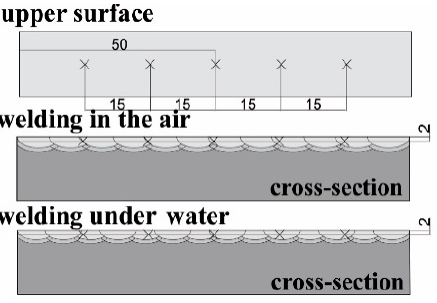
Figure 4. The scheme of the hardness measurement points.